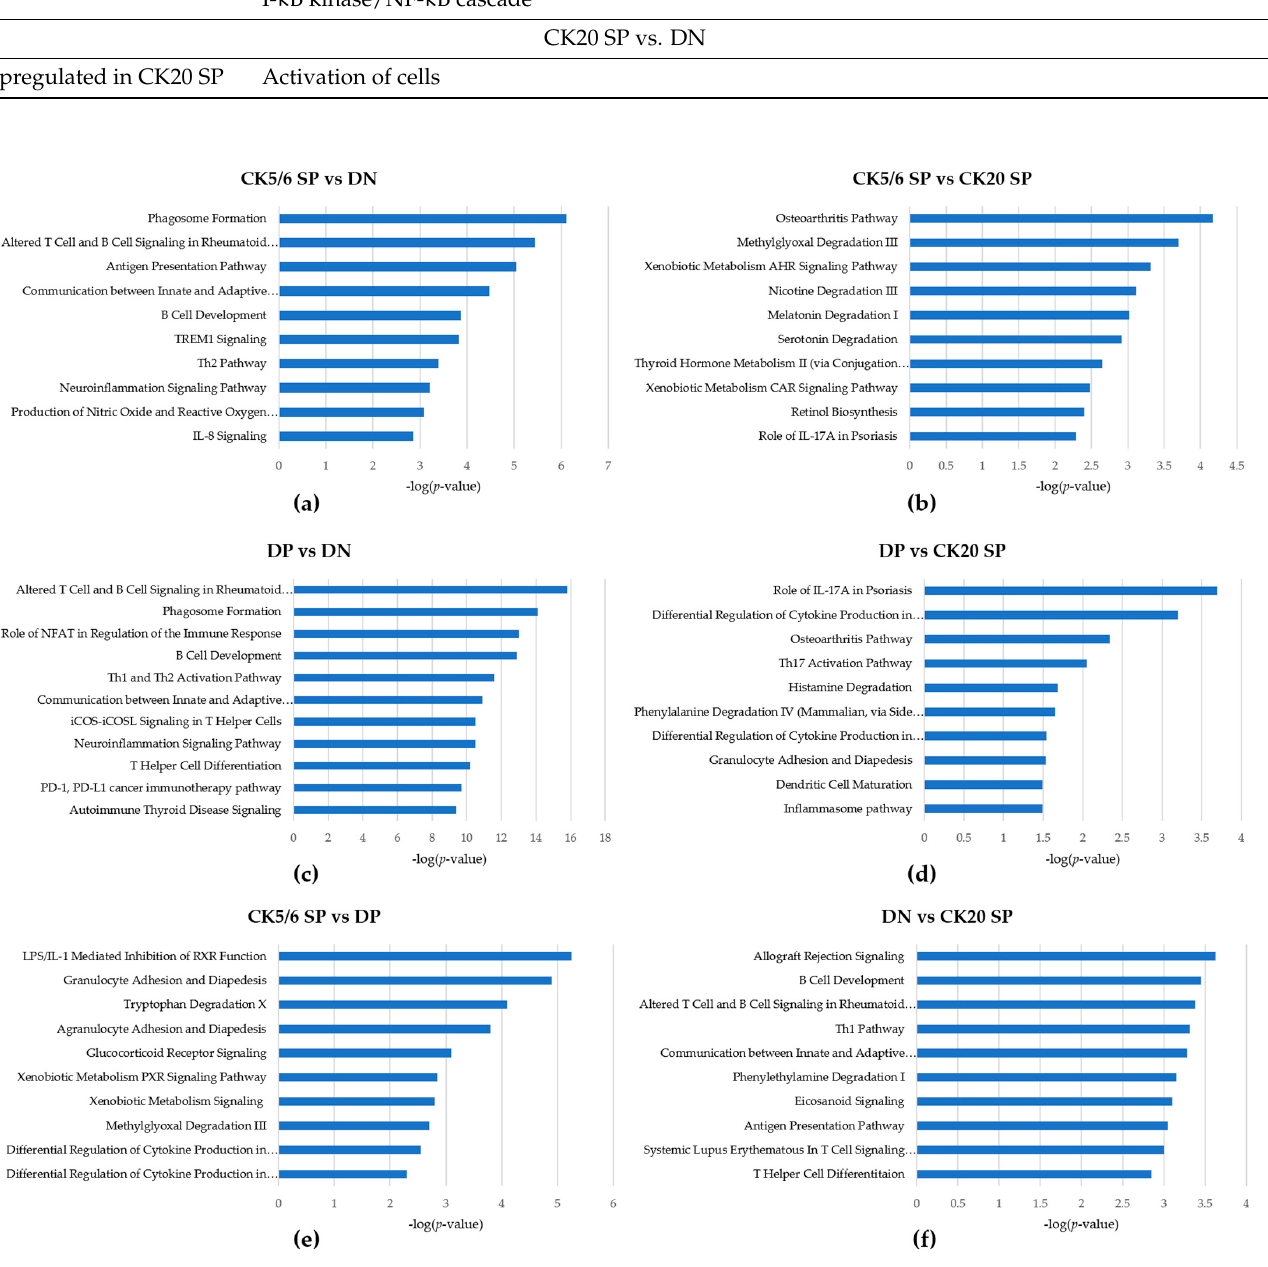
Figure 3. Ingenuity canonical pathways of DEGs between four subgroups: ( a ) CK5/6 SP vs. DN; ( b ) CK5/6 SP vs. CK20 SP; ( c ) DP vs. DN; ( d ) DP vs. CK20 SP; ( e ) CK5/6 SP vs. DP; ( f ) DN vs. CK20 SP.